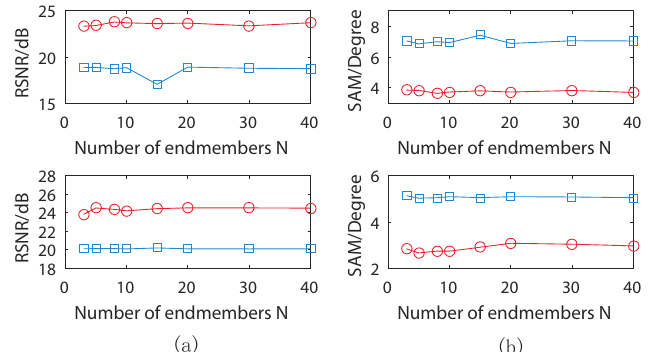
Figure 6. The performance curves of CNMF ( (cid:3) ) and the proposed JSMV-CNMF ( ◦ ), in terms of ( a ) reconstruction signal-to-noise ratio (RSNR) and ( b ) spectral angle mapper (SAM), with respect to the number of endmembers N for the two datasets; i.e., (top row) Pavia University and (bottom row) Moffett datasets,